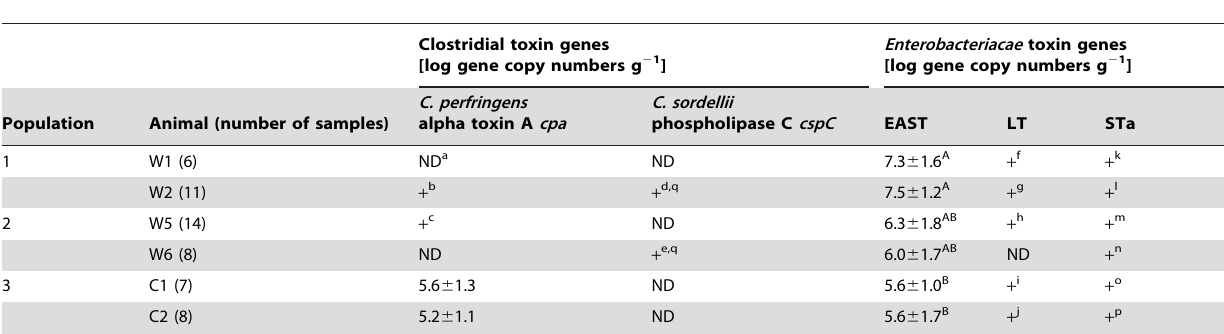
Table 2. Presence of pathogen toxin genes in feces of wild and captive grizzly